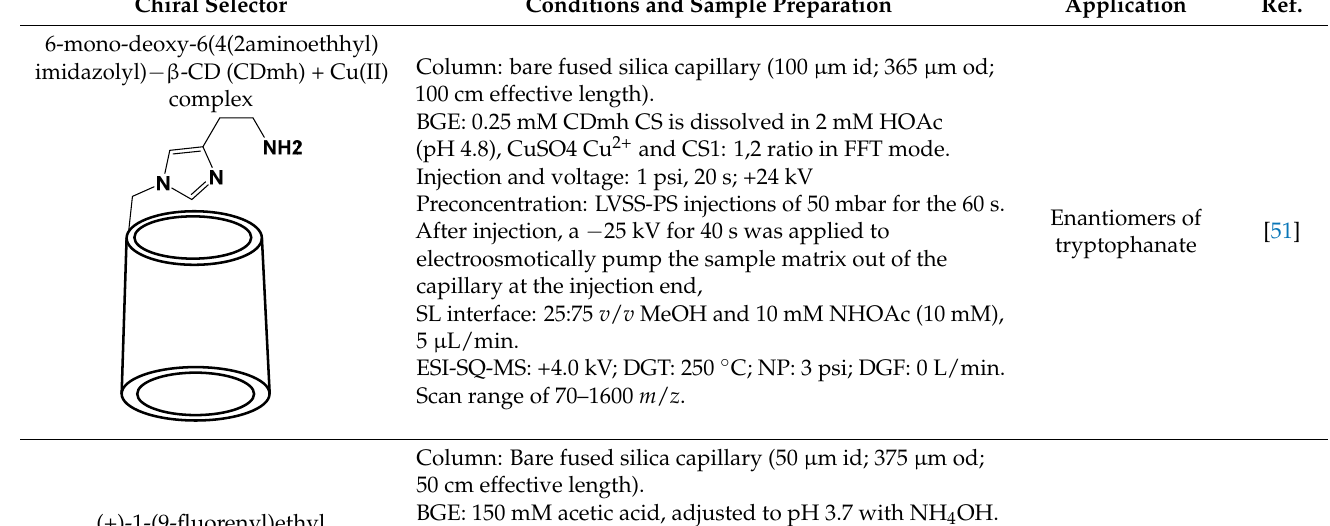
Table 1. Cont. Chiral Selector Conditions and Sample